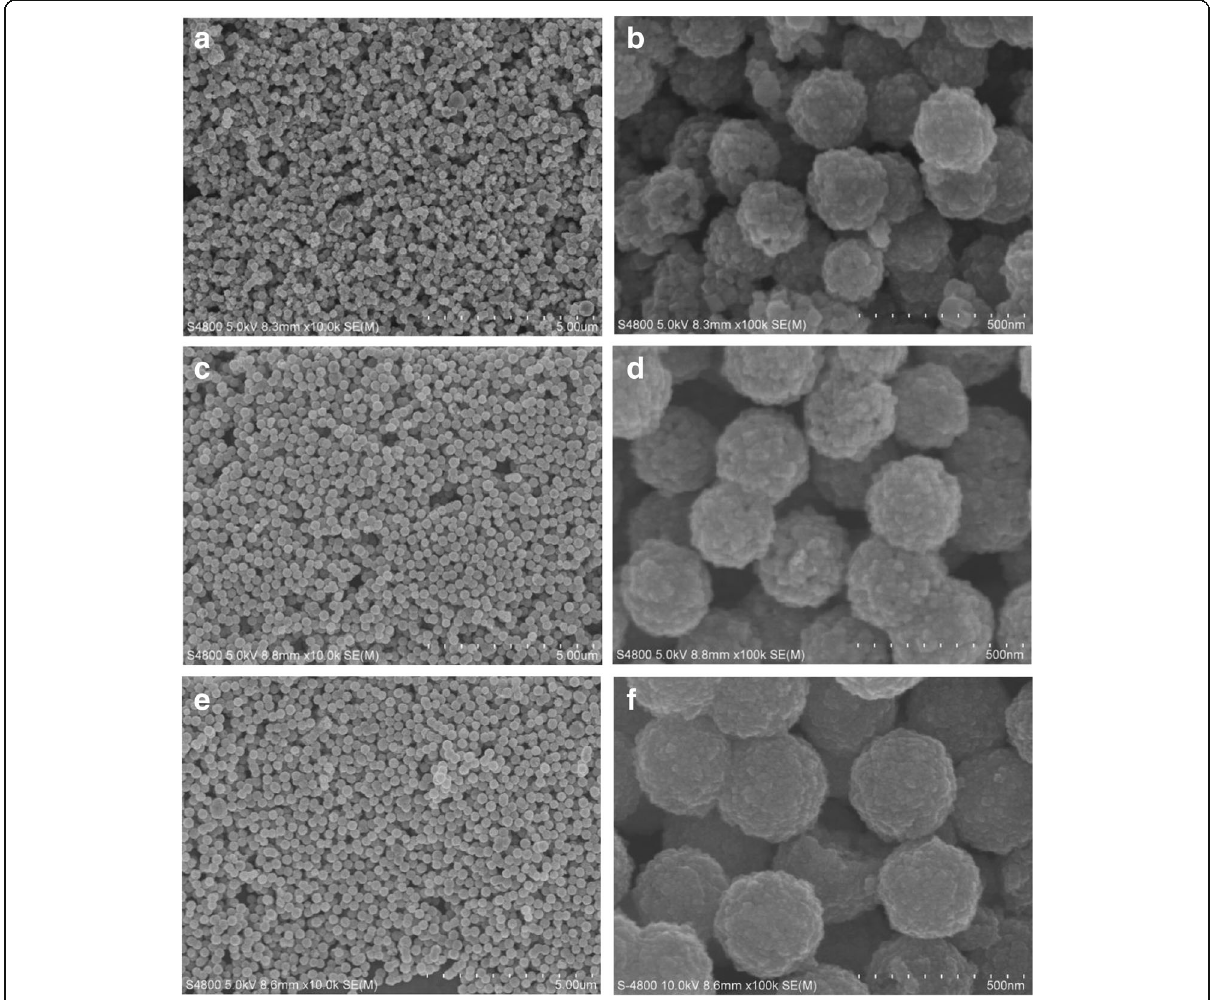
Fig. 8 SEM images of different amount of PAM synthesized sample. a , b 0.1 g. c , d 0.2 g e , f 0.3